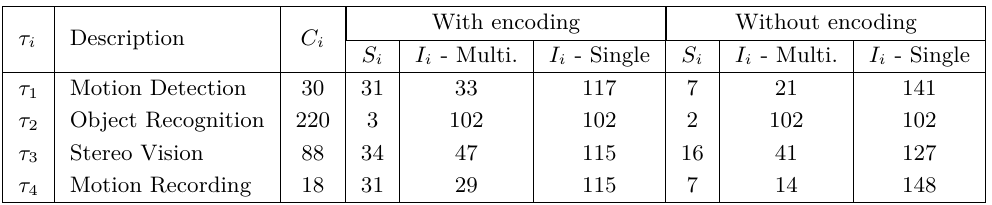
Table 1 Timing parameters of case study tasks